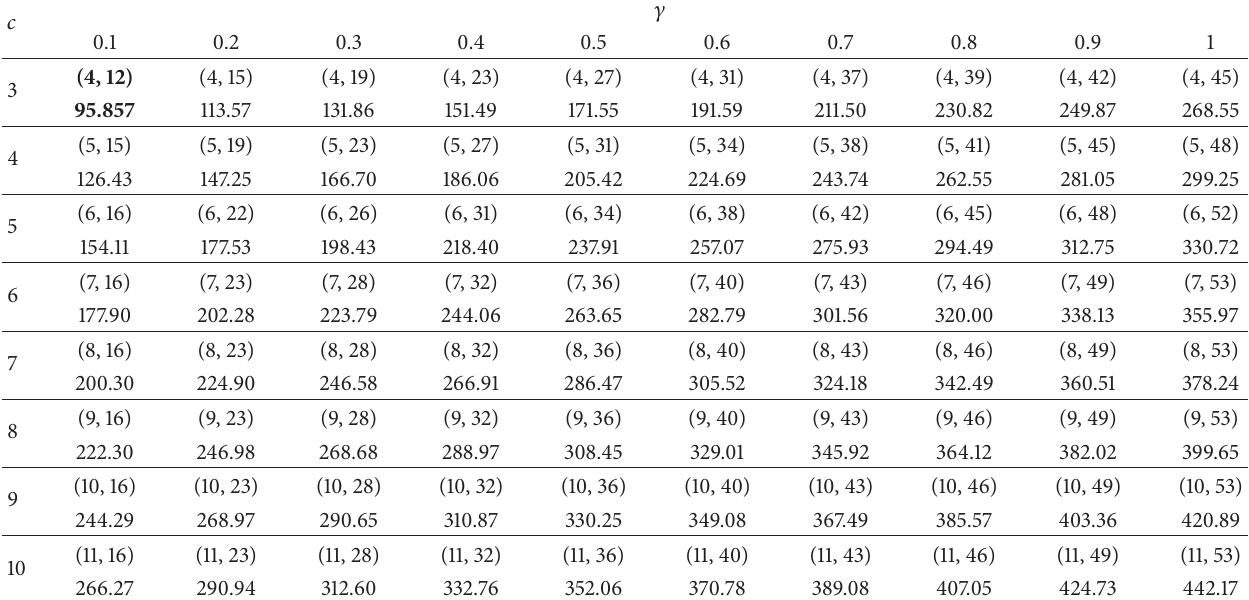
Table 3: Optimal (𝑠,𝑄) values and minimum